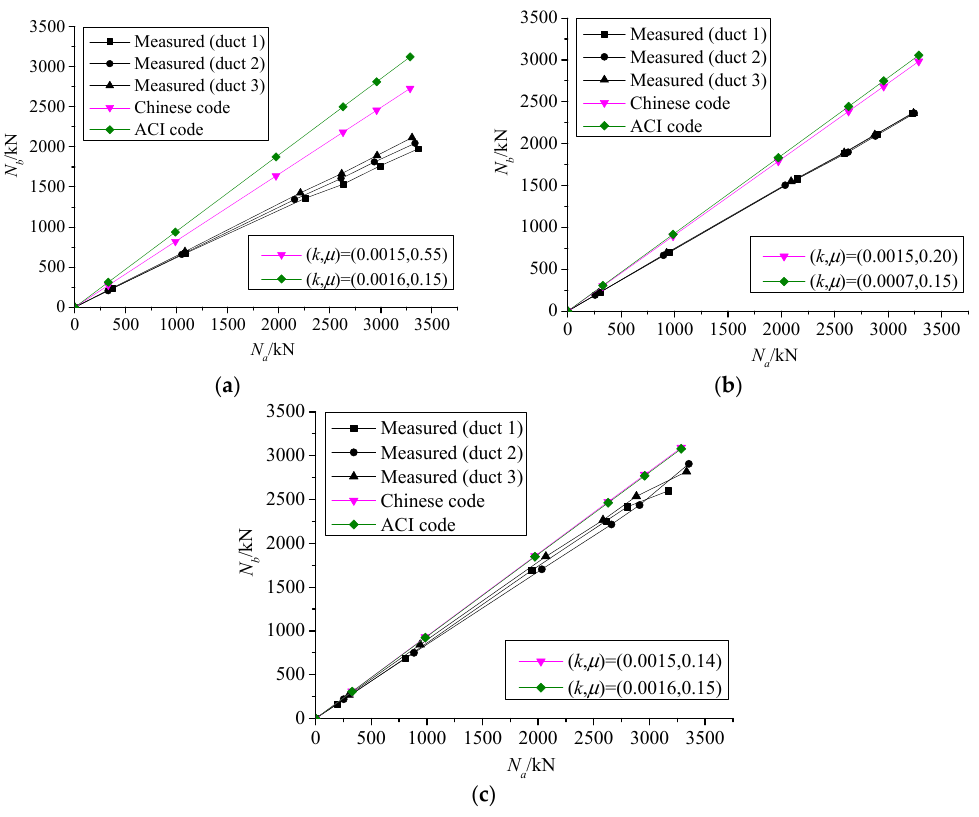
Figure 16. Pre-stress forces of specimens with 19 wires and curve duct based on Wujiang Bridge made of: ( a ) rubber hose; ( b ) metal bellow; and ( c ) plastic bellow.